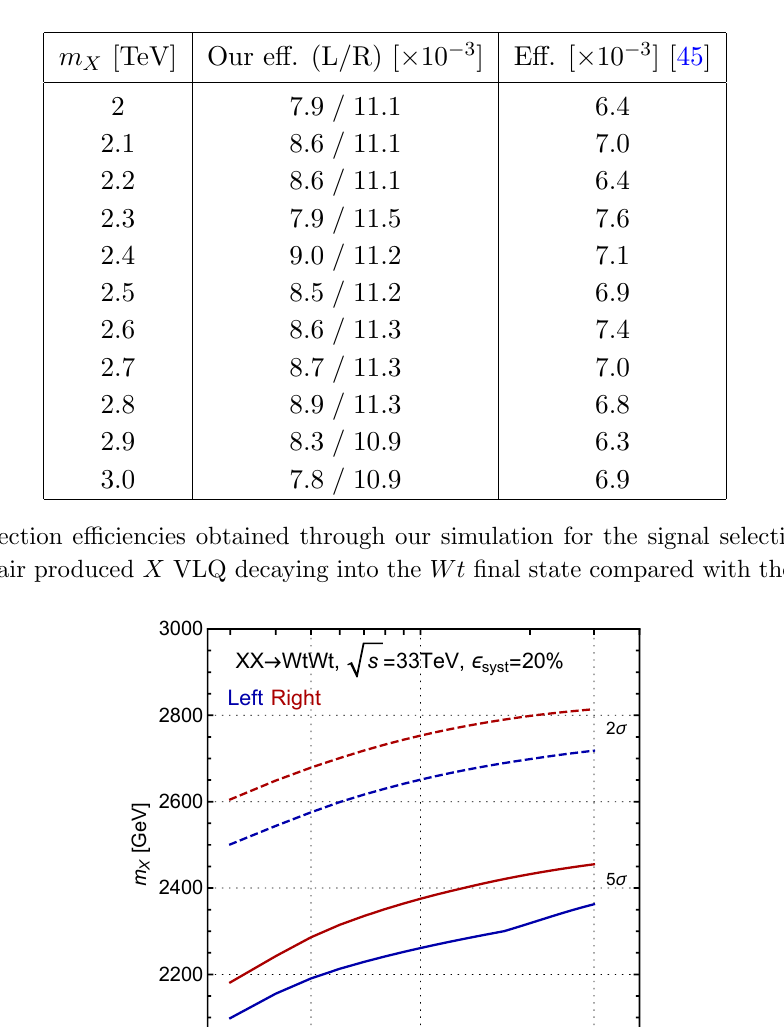
p s = 33 TeV hadron collider. The